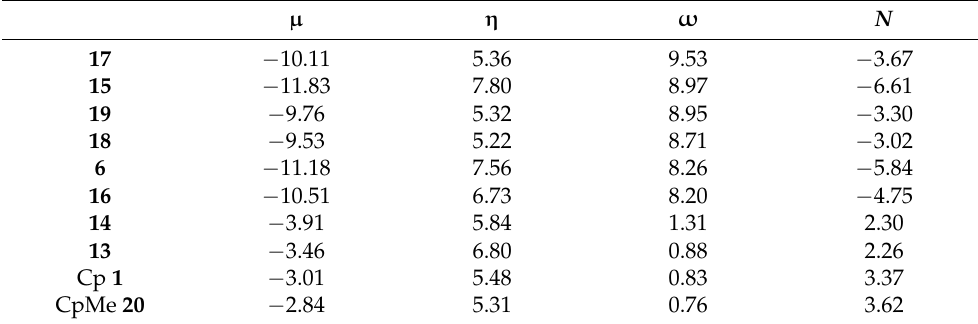
Table 1. B3LYP/6-31G(d) Global reactivity indices, the electronic chemical potential, µ , chemical hardness, η , electrophilicity, ω , and nucleophilicity, N , in eV, of imines 8 and 9 , iminium cations 1 – 6 , and Cp 7 .